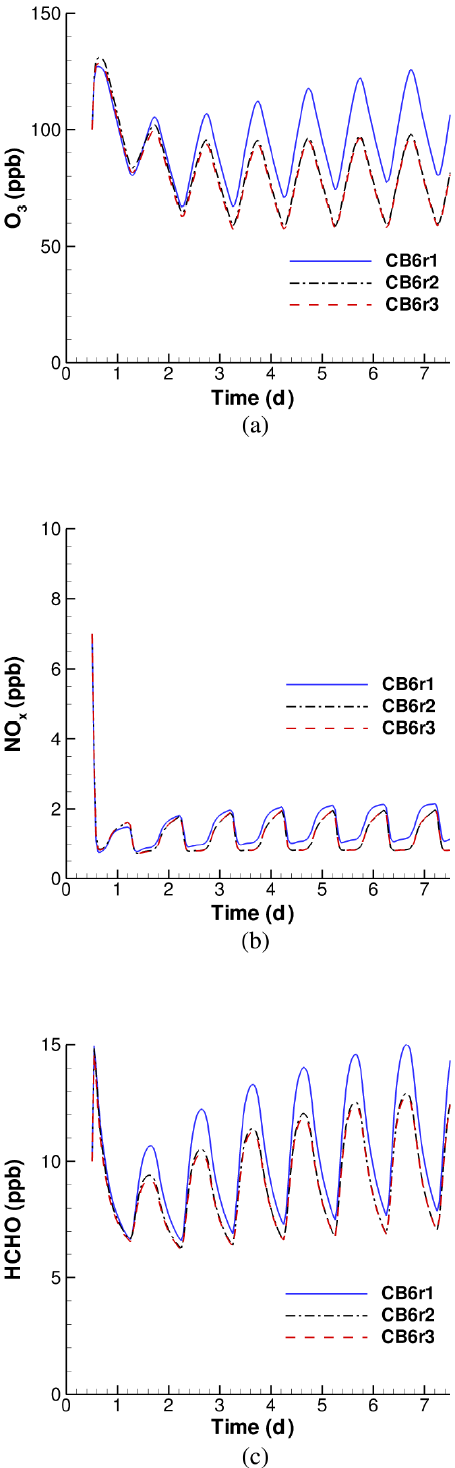
Figure 5. Simulated temporal evolution of O 3 , NO x and HCHO by using different versions of the CB6 mechanism, when the surface emission is